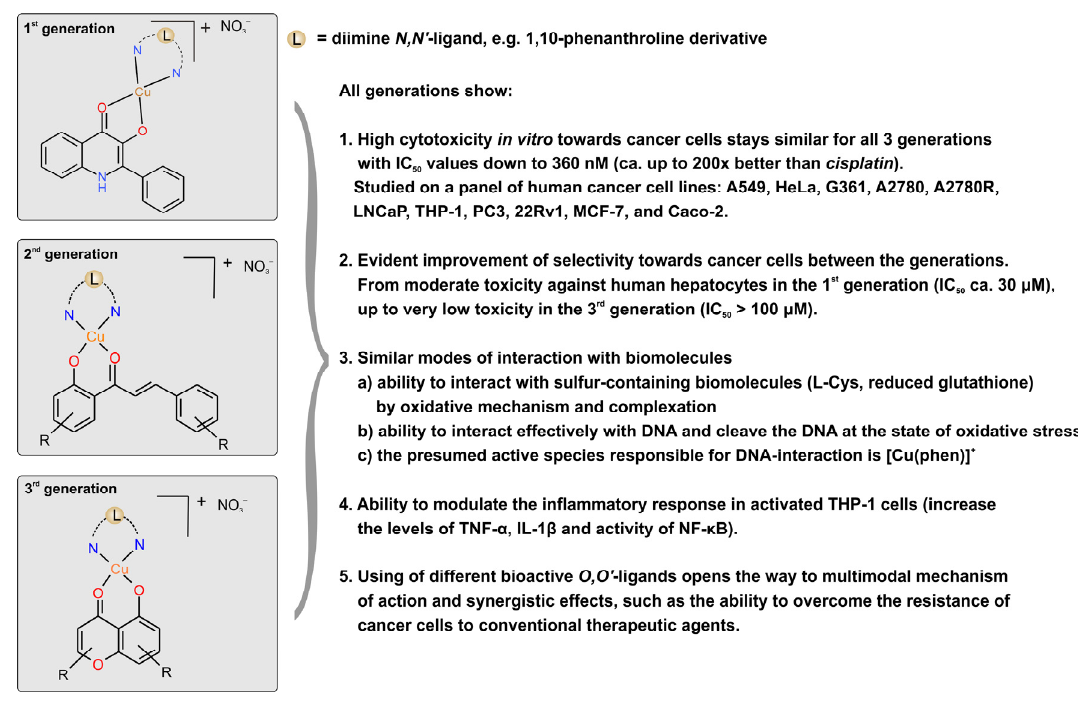
Figure 4. The overview of structural types of studied generations of mixed-ligand copper(II) complexes and their biological activities.